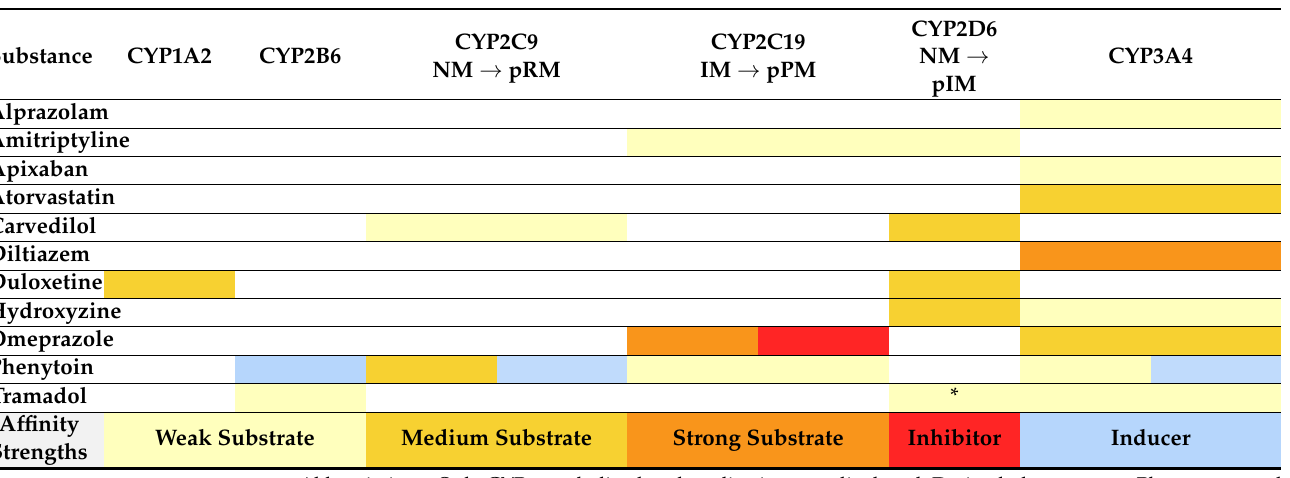
Table 3. Summary of affinity and CYP450 metabolic pathway.